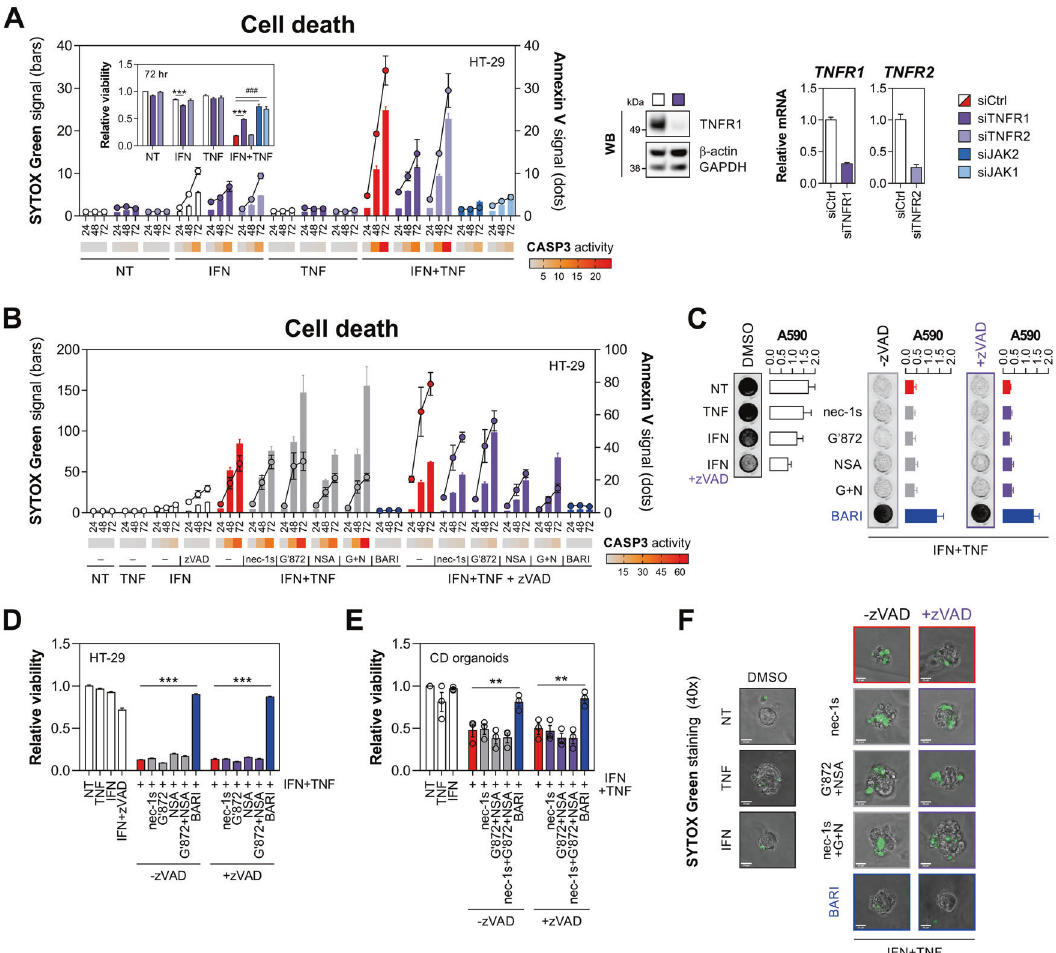
Fig. 4 IFN- γ and TNF- α kill IECs through non-canonical TNFR1 signalling. A HT-29 cells were transfected with a nontargeting siRNA (siCtrl), siTNFR1, siTNFR2 or positive control siRNA ’ s (siJAK1, siJAK2), followed by IFN- γ /TNF- α (10 ng/ml each). SYTOX Green/Annexin V signals and caspase-3 activity (heatmap) were recorded at indicated times, and relative viability was measured at 72 h (inner graph). Western blot and RT- qPCR validation of TNFR1/2 knockdown (right). B – D HT-29 cells were pretreated for 1 h with vehicle (DMSO), RIPK1 inhibitor (necrostatin-1s, 10 μ M), RIPK3 inhibitor (GSK ′ 872, 10 μ M), MLKL inhibitor (NSA, 1 μ M), dual JAK1/2 inhibitor (baricitinib, 10 μ M) alone or in combination with a pan-caspase inhibitor (zVAD, 20 μ M), followed by IFN- γ /TNF- α (10 ng/ml each). B SYTOX Green/Annexin V signals and caspase-3